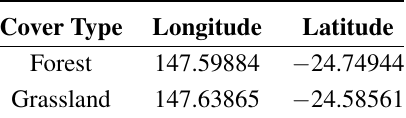
Table 1. Locations of example points used for time series